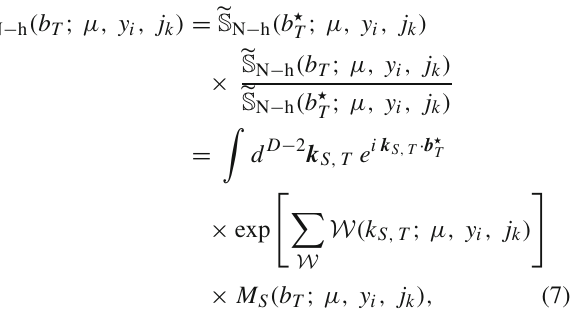
of perturbative and non-perturbative parts (see Ref.